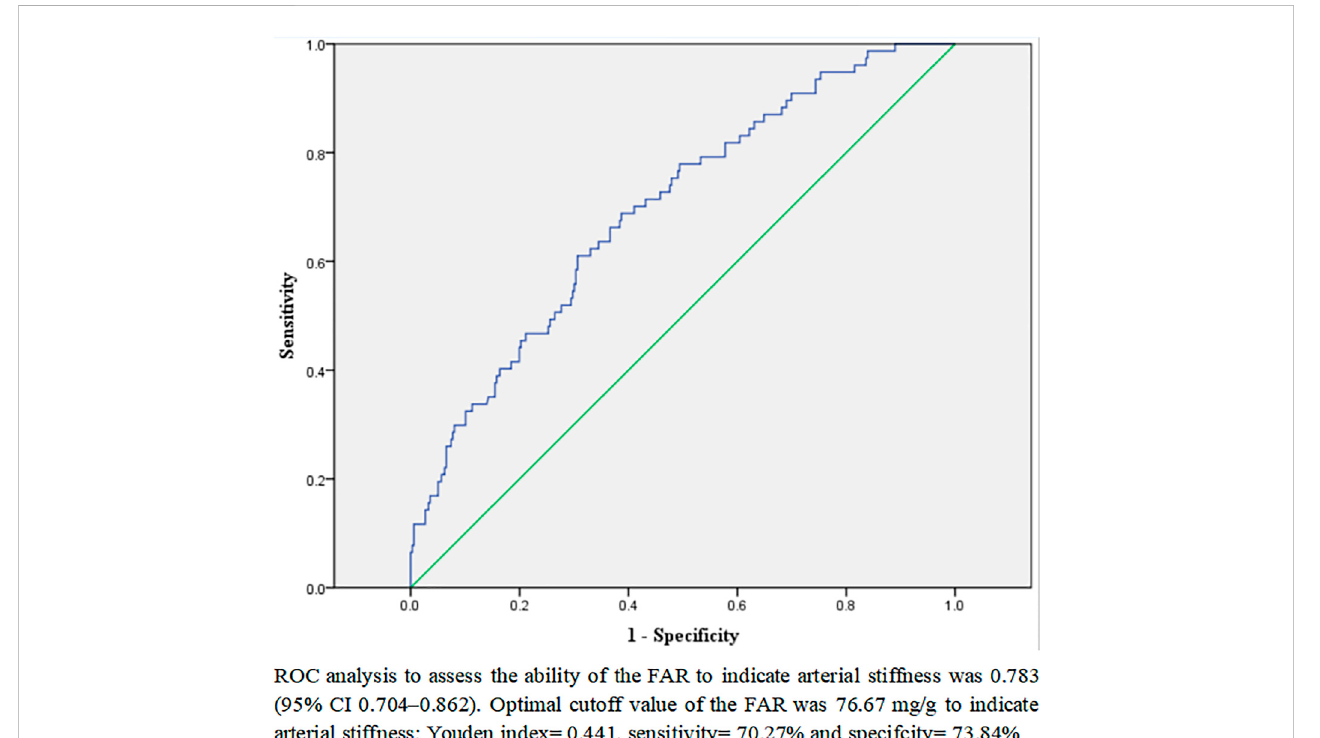
FIGURE 2 ROC analysis to analyze the ability of the FAR to indicate arterial stiffness in male patients with